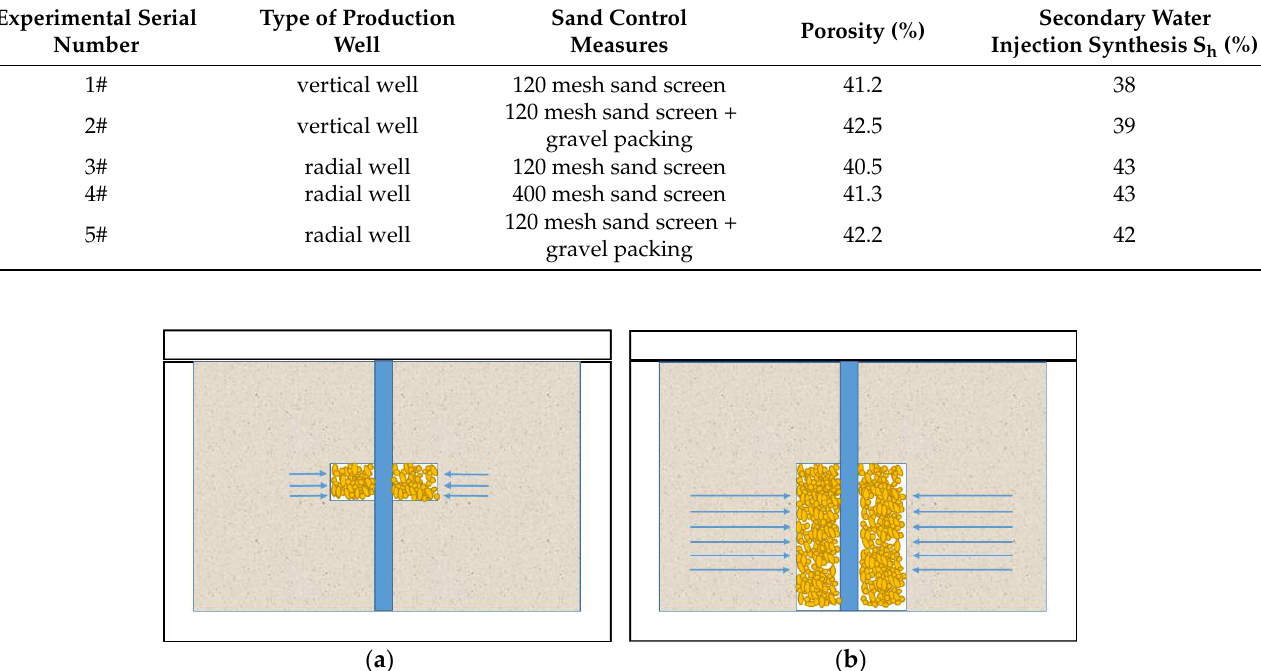
Figure 7. Schematic diagram of depressurization of hydrate specimens: ( a ) vertical well; ( b ) radial wells.